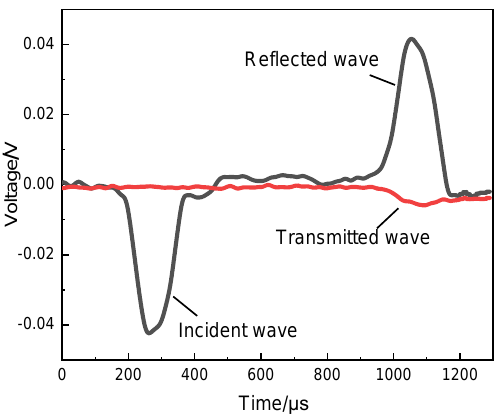
Figure 5. Typical waveform curve of the sample SHPB experiment.